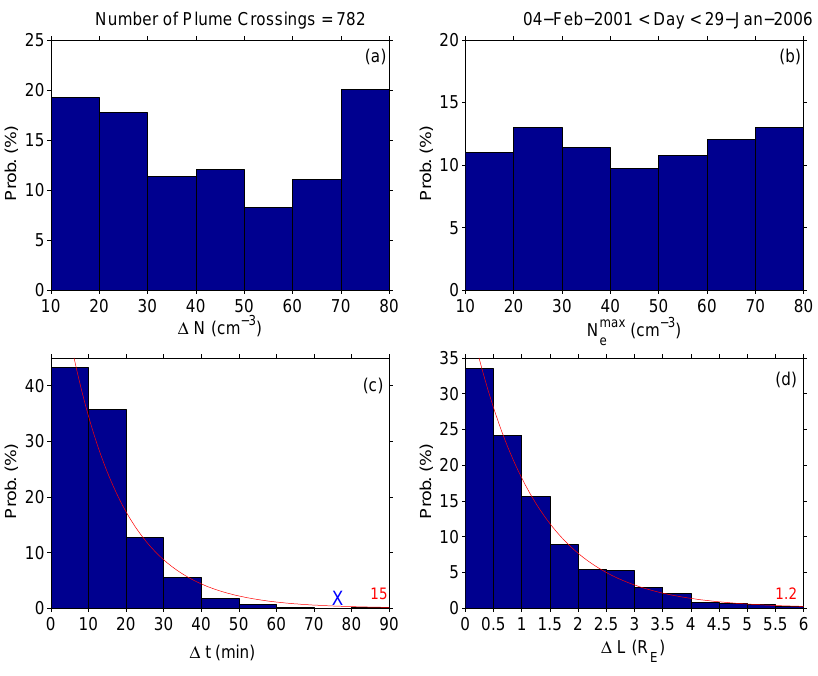
Fig. 10. Typical characteristics of the plasmaspheric plumes observed by WHISPER during the five years of Cluster data analysed. (a) Prob- ability of the density variation 1N inside the plumes. (b) Probability of the maximum density N max e inside the plumes. (c) Probability of the time duration 1t of the plume crossings. (d) Probability of the width 1L of the plumes. A blue cross means no data in this range. The red curves are exponential least-square fitting curves.